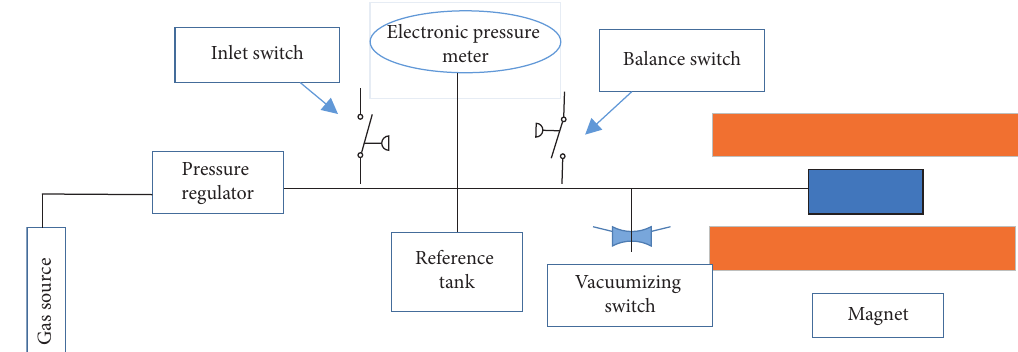
Figure 2: Schematic representation of adsorption-desorption experiment device.